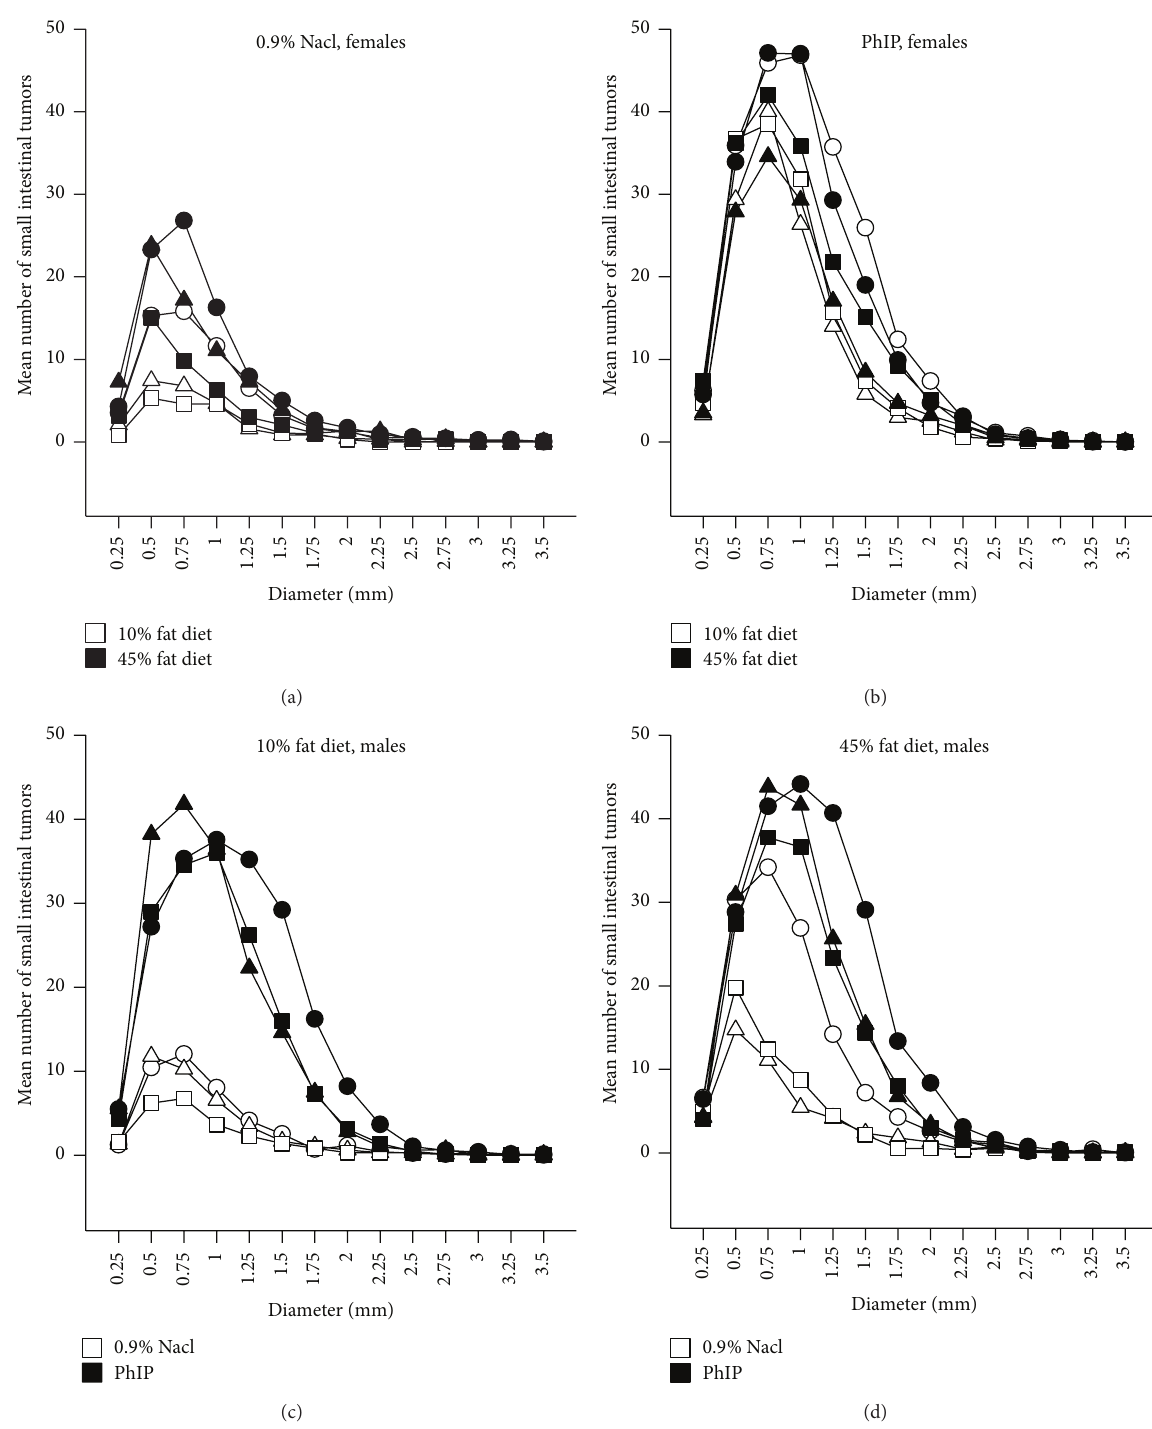
Figure3:Thesizeofthesmallintestinaltumors.Thisisillustratedbycurvesofdistributionsoftumorssizeclasses(of0.25mmtumordiameter intervals) calculated as mean number of tumors in each tumor size class for each treatment group. The effect of a 45% fat diet compared with a 10% fat diet is shown for female Apc Min/+ X Lep ob/ob mice ( I ), Apc Min/+ X Lep ob/wt ( 󳵻 ) and Apc Min/+ X Lep wt/wt mice ( ◻ ) on a 10% fat diet, and the same genotypes on a 45% fat diet (filled symbols) exposed to (a) 0.9% NaCl, or (b) PhIP. The effect of exposure to PhIP compared with 0.9% NaCl is shown for male Apc Min/+ X Lep ob/ob mice ( I ), Apc Min/+ X Lep ob/wt ( 󳵻 ) and Apc Min/+ X Lep wt/wt mice ( ◻ ) exposed to 0.9% NaCl, or the same genotypes exposed to PhIP (filled symbols) on (c) a 10% fat diet, or (d) a 45% fat diet. 𝑛 = 10 –17